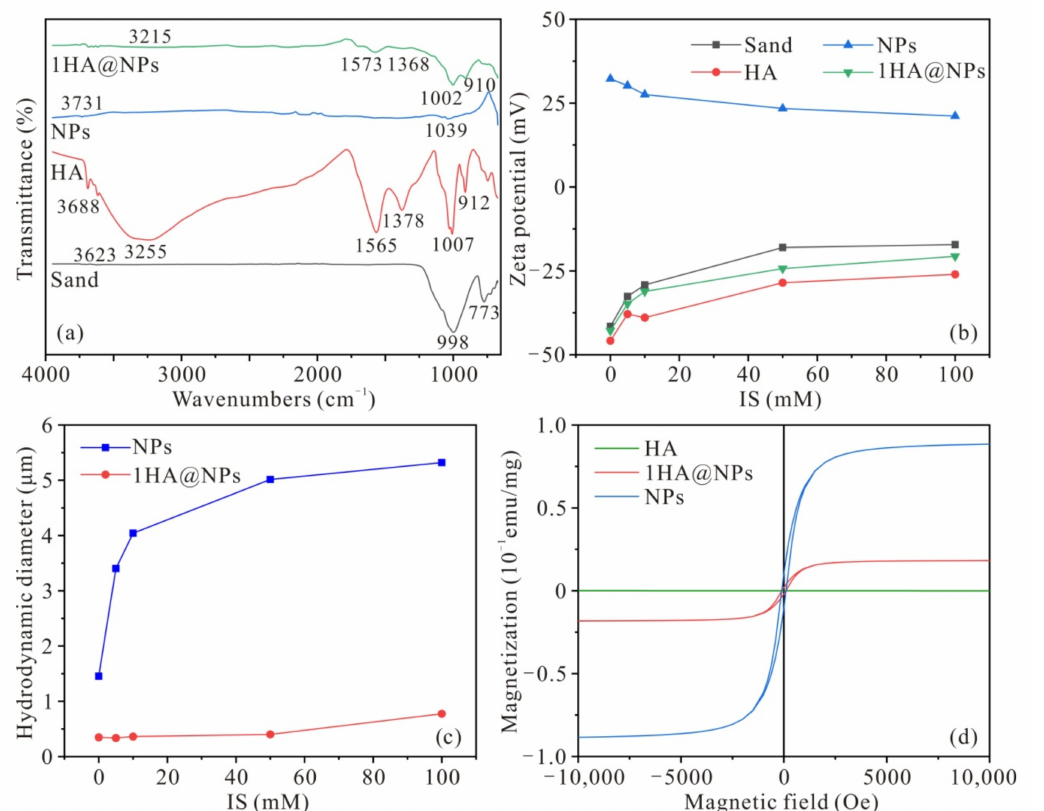
Figure 2. ( a ) Fourier transform infrared (FTIR) spectra of humic acid (HA), iron oxide (Fe 3 O 4 ) nanoparticles (NPs), 1HA@NPs, and sand. ( b ) Influence of IS on the zeta potential of HA, Fe 3 O 4 NPs, 1HA@NPs, and sand. ( c ) Influence of ion strength (IS) on the hydrodynamic diameter of Fe 3 O 4 NPs and 1HA@NPs. ( d ) The hysteresis loops of HA, Fe 3 O 4 NPs and